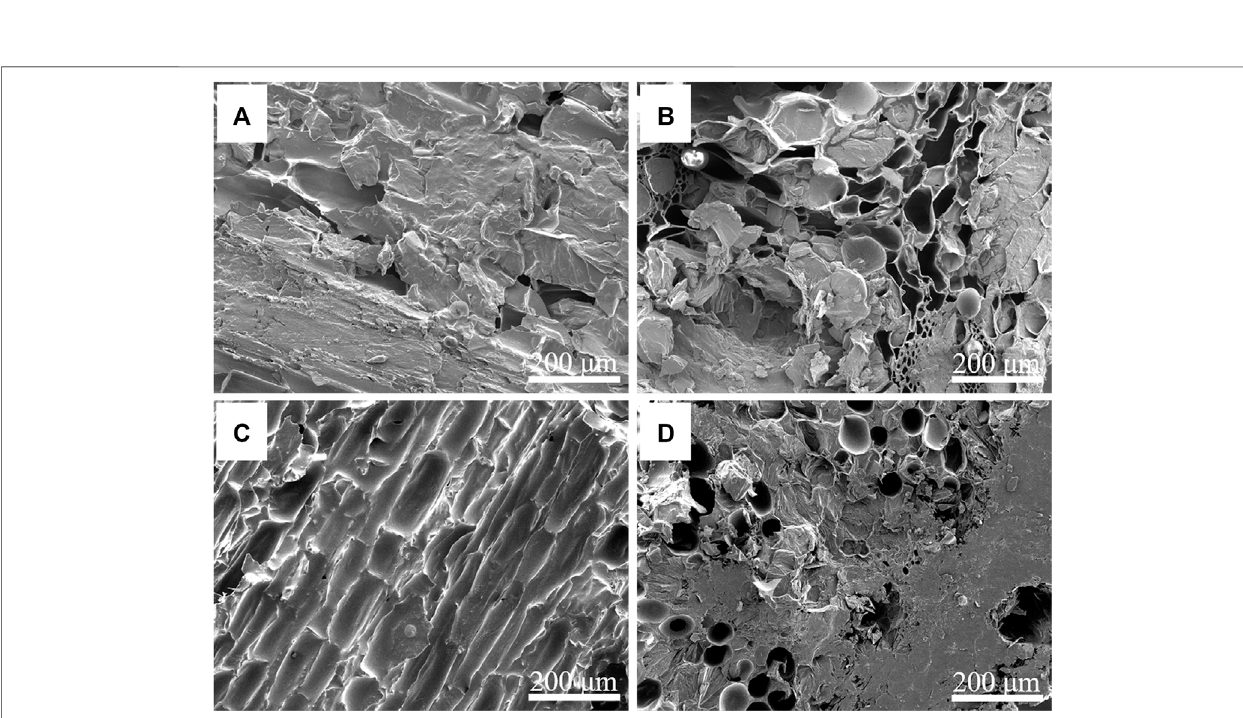
FIGURE 3 | SEM images of longitudinal-sectional and cross-sectional NC/PEG (A,B) and 310/PEG (C,D) .